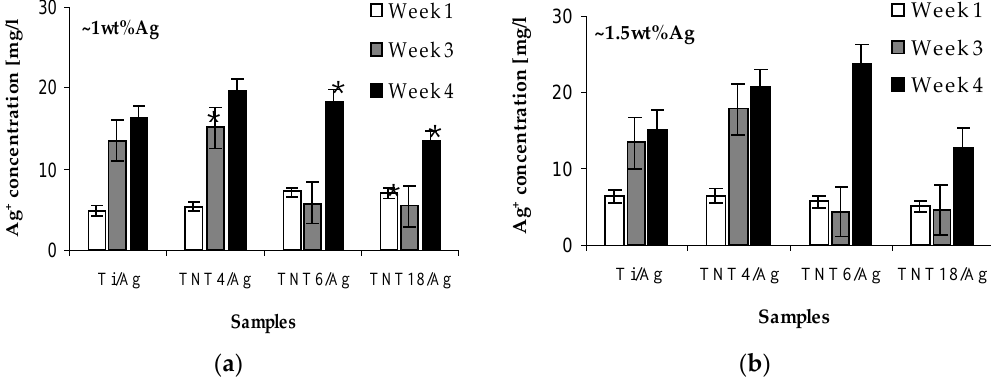
Figure 2. Silver ions release from TNT/Ag coatings containing 1 wt% Ag ( a ) and 1.5 wt% Ag; ( b ) immersed in phosphate-buffered saline (PBS) solutions. Asterisk indicates significant differences between tested and control surfaces (* p ≤ 0.05)